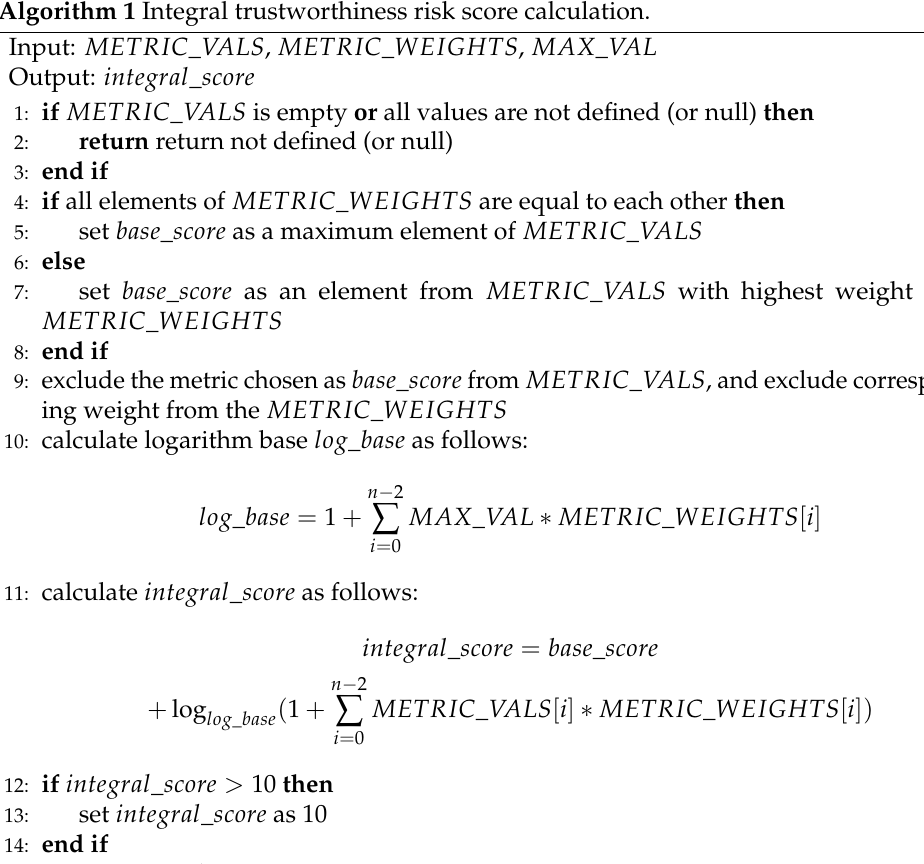
Algorithm 1 Integral trustworthiness risk score